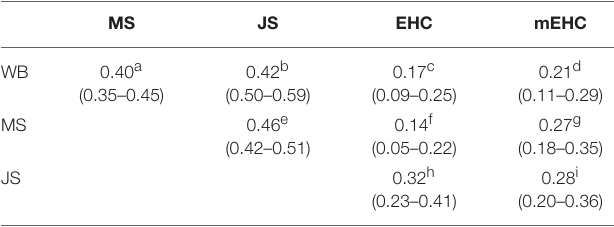
TABLE 3 | Correlation matrix for interrelationship of the test